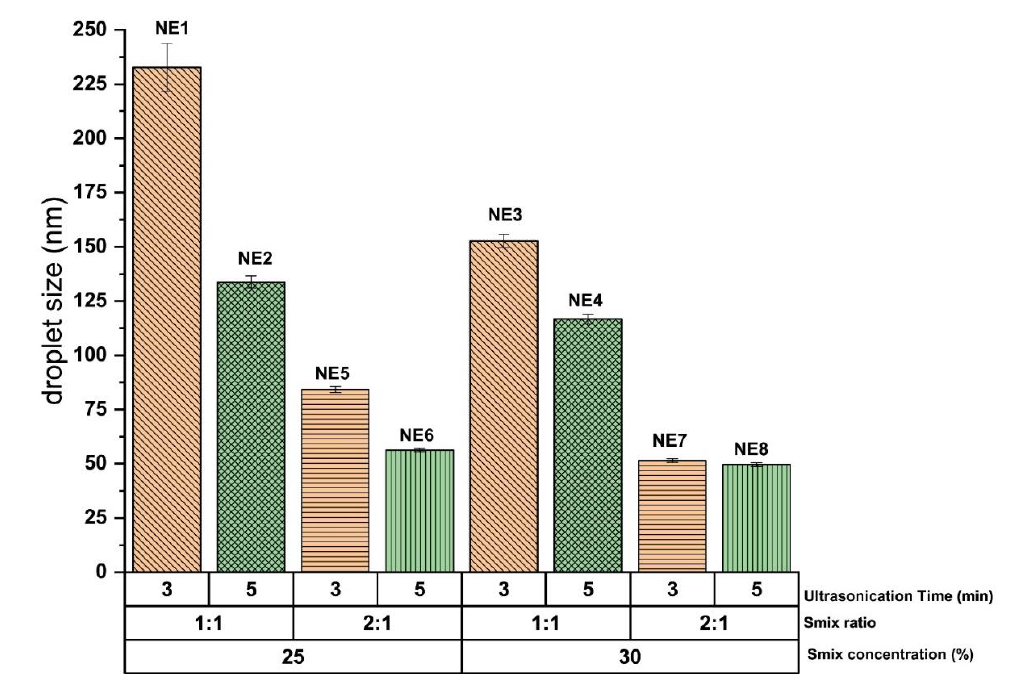
Figure 1. Impact of the process variable (ultrasonication time 3 and 5 min) and composition variables (Smix ratio and % concentration) on droplet size of NE system generated through high-energy ultrasonication technique at Smix concentration 25% (Smix ratio 1:1 and 2:1) and Smix 30% (Smix ratio 1:1 and 2:1). Colors and shaded bars represent variability in formulation compositions and process conditions.